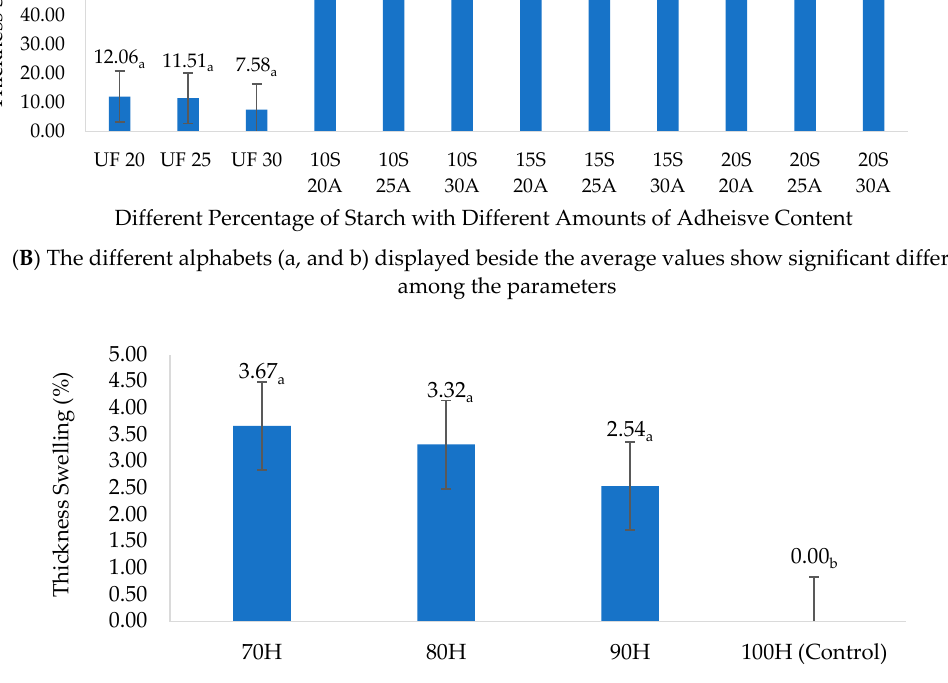
Figure 2. Average thickness swelling for ( A ) seaweed-based adhesive particleboard, ( B ) starch-based particleboard, ( C ) WPC.